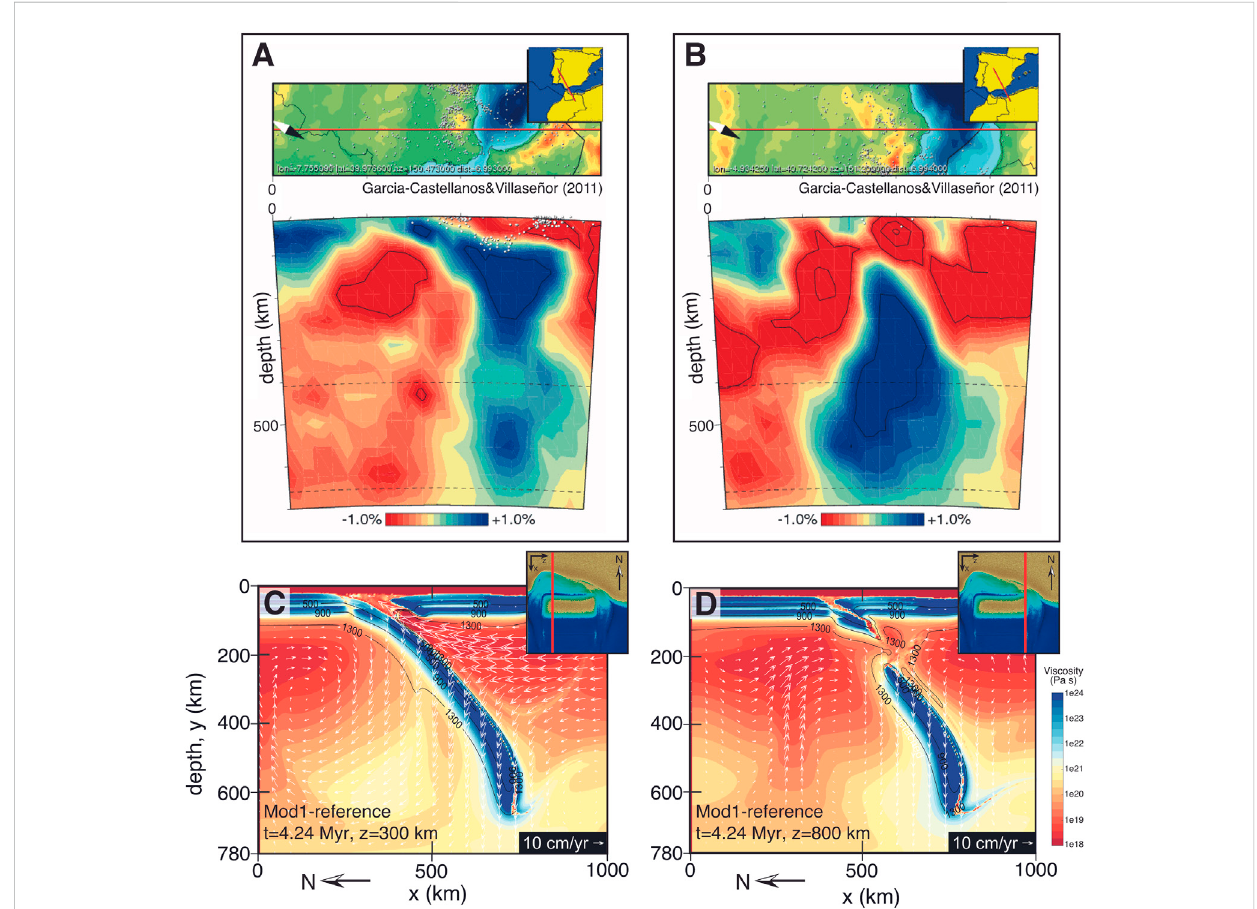
FIGURE 9 ComparisonofslabstructurefromMod1-referencewiththeseismictomographyofthewesternMediterranean. (A) and (B) areseismictomographic images from Garcia-Castellanos and Villaseñor (2011) showing the distribution of fast- (blue) and slow-seismic-velocity (red). (C) and (D) are viscosity cross-sections from model Mod1-reference with (C) sliced from z = 300 km, where the subducting slab is still attached and (D) sliced from z = 800 km, where the slab has just started tearing. The subsets in (C) and (D) show the plan-view (x – z) of the surface elevation, and the red lines indicate the position of the corresponding cross-sections. The cross-sections from Mod1-reference resemble, to an extent, the seismic tomography from the western Mediterranean, with the attached portion of the slab on the NW side (A) and the detached slab toward the NE side (B)